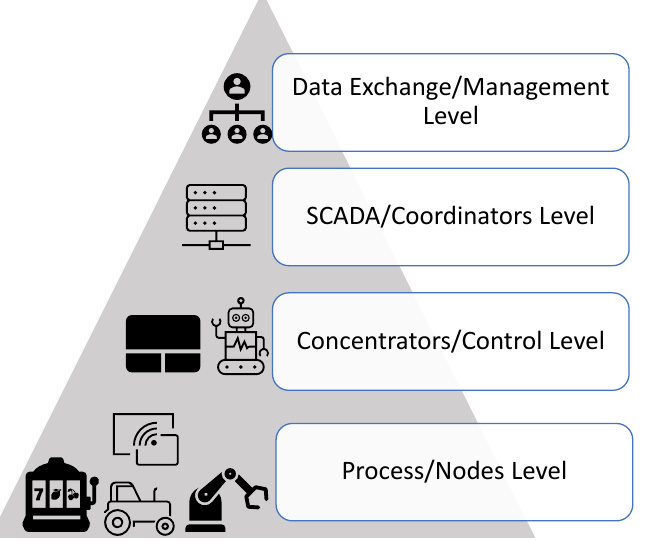
Figure 1. Structured process automation showing four critical levels of data